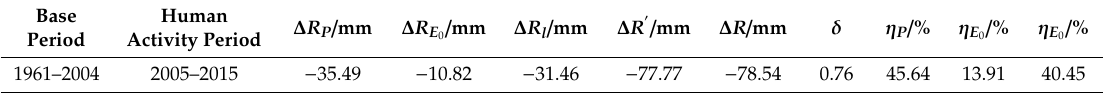
Table 5. Contribution of hydro–meteorological variables to runo ff depth